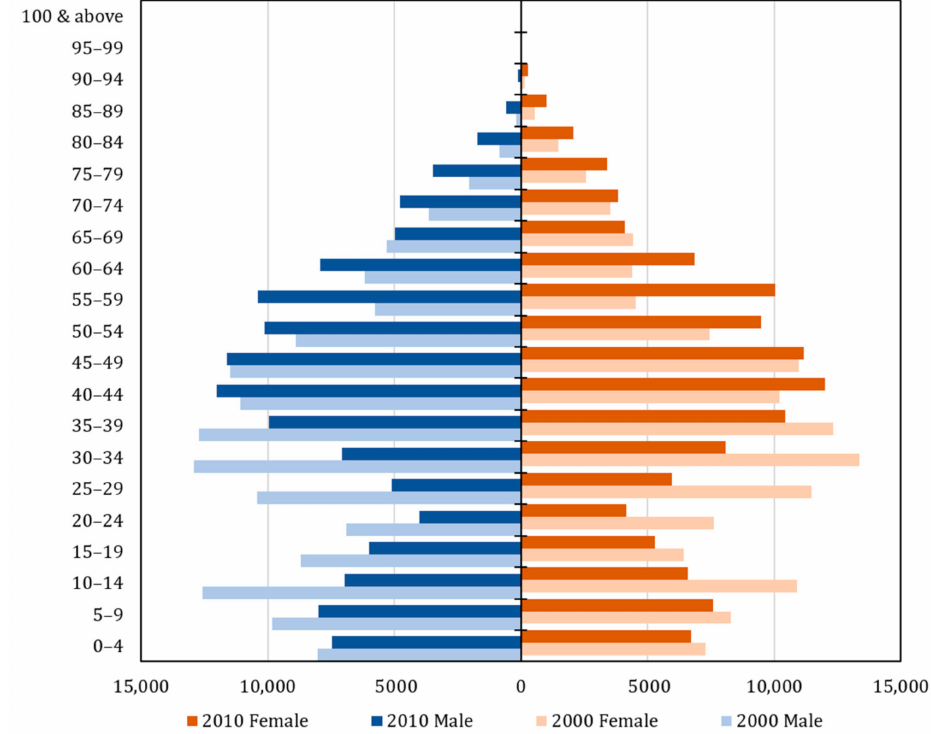
Figure 3. Variation diagram of population age structure in Changshan County during